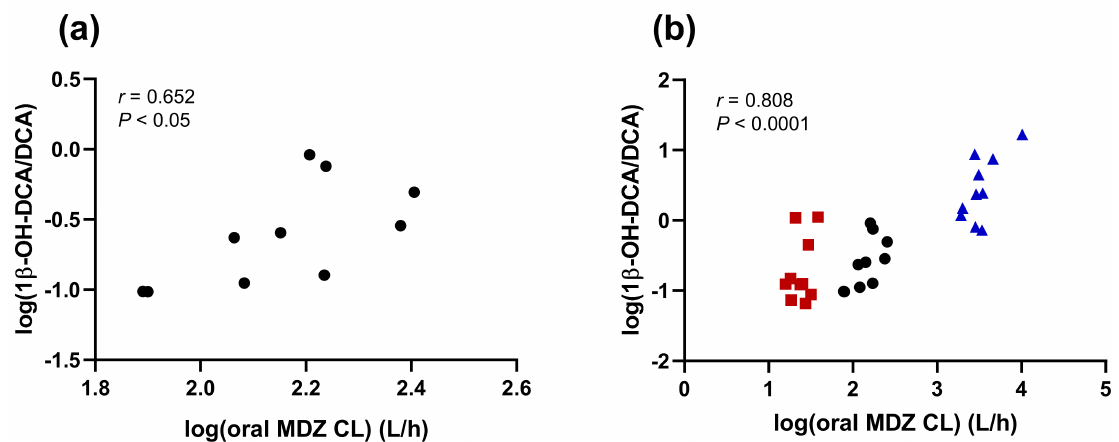
Figure 4. Correlation between log-transformed 1 β -hydroxy-deoxycholic acid/deoxycholic acid urinary metabolic ratio and oral midazolam clearance after ( a ) the administration of midazolam alone and after ( b ) the administration of midazolam alone and after pretreatment with voriconazole/fluvoxamine or rifampicin. Black circles, baseline; CYP3A4-inhibited phase, red square; CYP3A4-induced phase, blue triangles. 1 β -OH-DCA/DCA, 1 β -hydroxy-deoxycholic acid/deoxycholic acid; CL, clearance; MDZ,